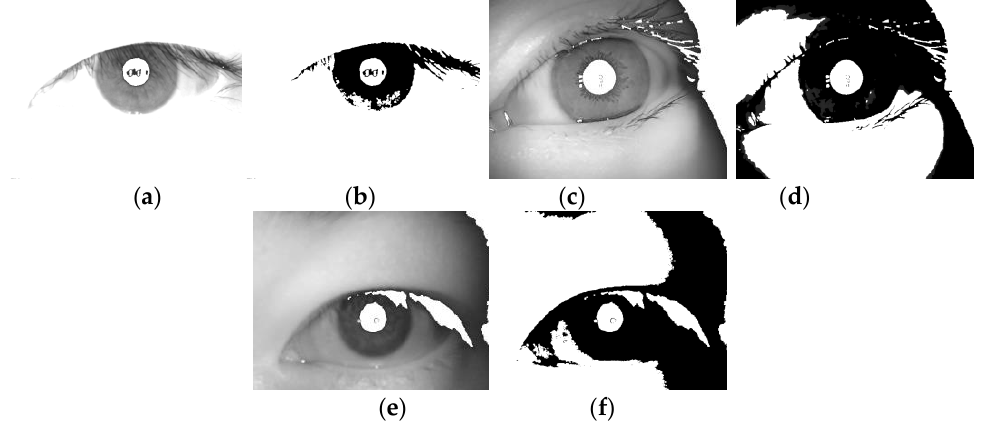
Figure 9. The transition processed image. ( a ) The transition processed image of Figure 1b, ( b ) the image of Figure 8a corresponds to the connected area, ( c ) the transition processed image of Figure 1d, ( d ) the image of Figure 8c corresponds to the connected area, ( e ) the transition processed image of Figure 1f, ( f ) the image of Figure 8e corresponds to the connected area.